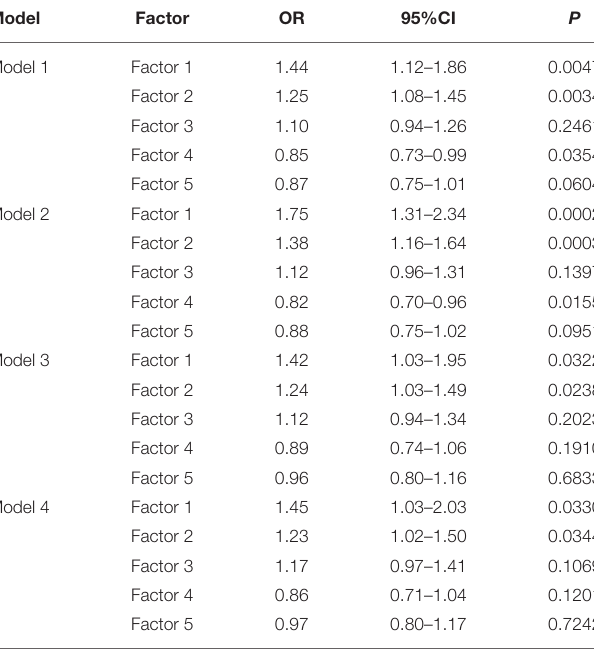
TABLE 3 | Factor and their loadings derived by 25 acylcarnitine metabolites. Variables